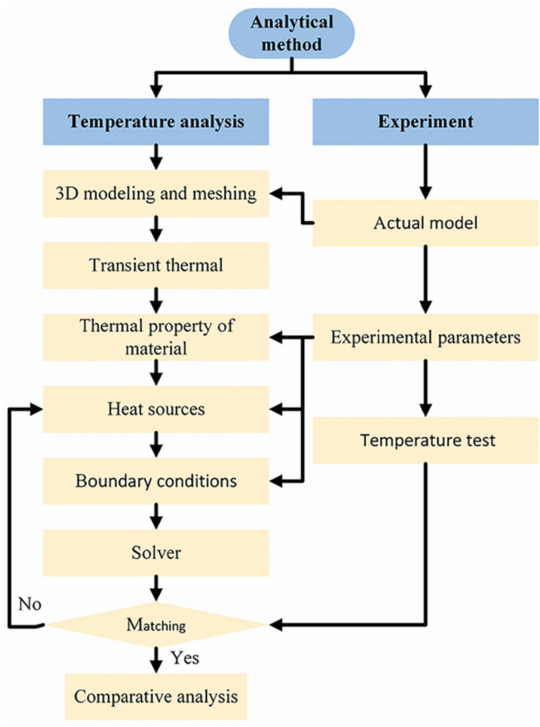
Figure 3. FEM simulation framework.